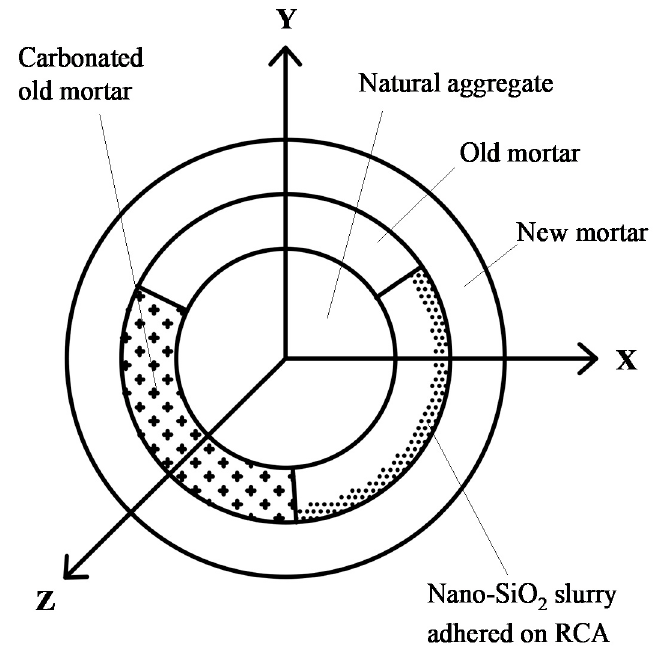
Figure 3. RAC model and strengthening schematic diagram of RCA.